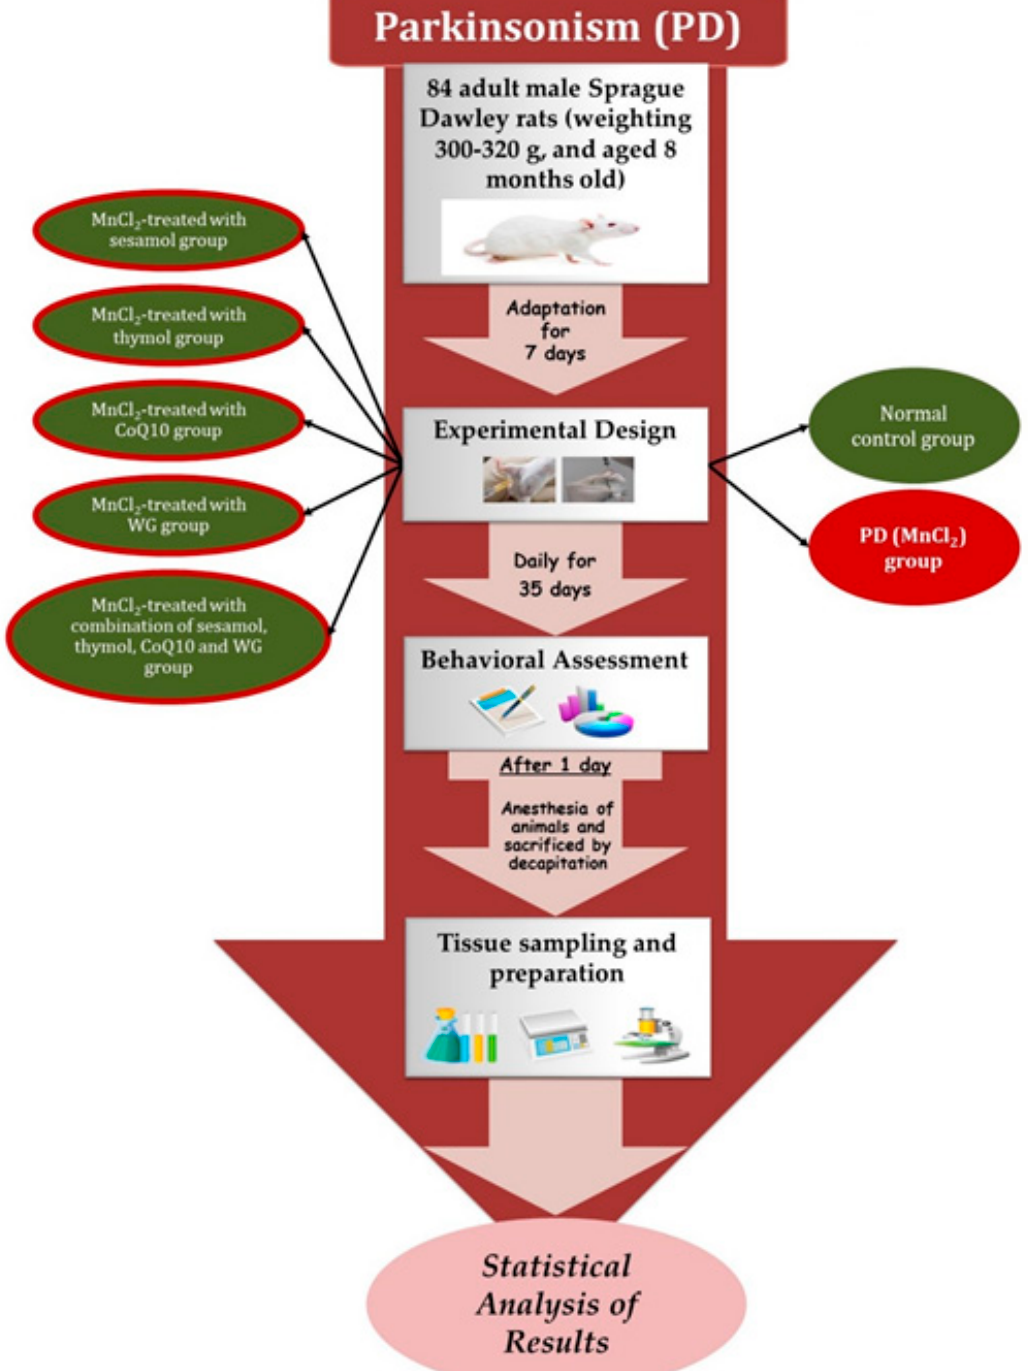
Figure 10. Summary of the experimental design and all behavioural and biochemical tests.